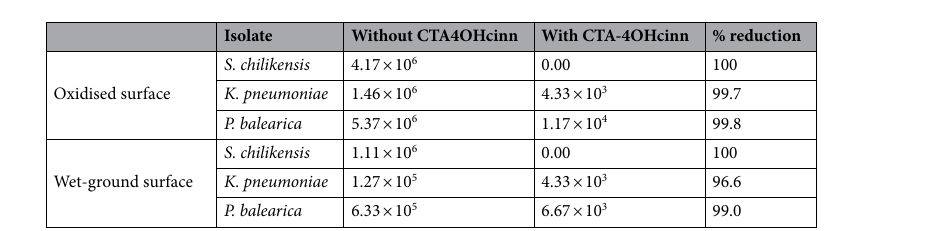
Table 1. Cell numbers attached to oxidised and wet-ground surfaces before and after exposure to 10 mM of CTA-4OHcinn for each isolate. Original values for surface colonisation are taken from Fig.